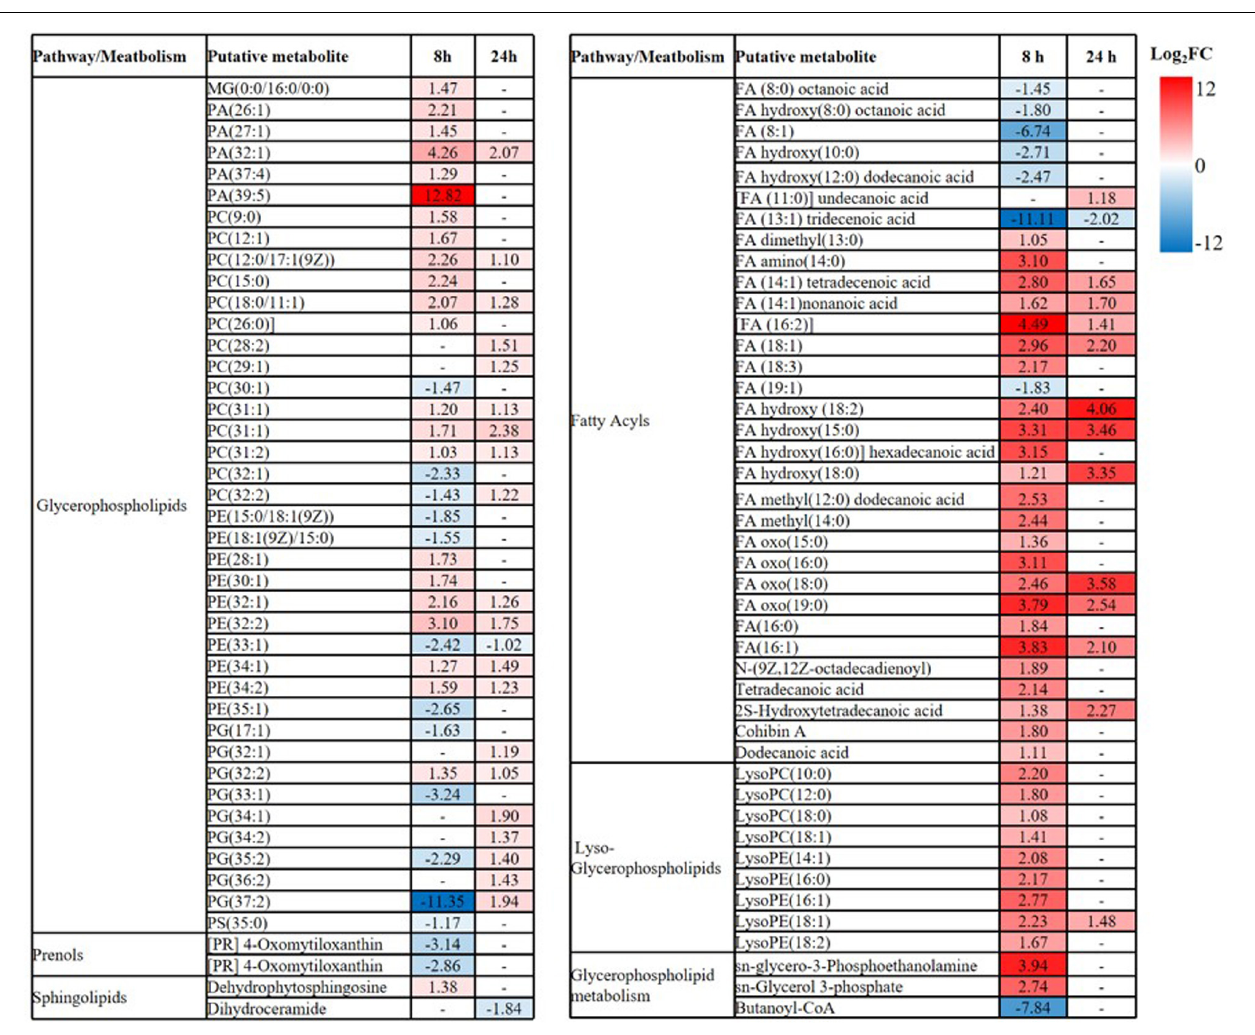
FIGURE 5 | Perturbations of lipids and related metabolites. Lipid names are putatively assigned based on accurate mass. The values and whether metabolite level decreased (blue) or increased (red) are shown. The heatmap is shown to the right of the table with the log 2 fold change (FC) values. FDR < 0.05, p < 0.05 and fold change ≥